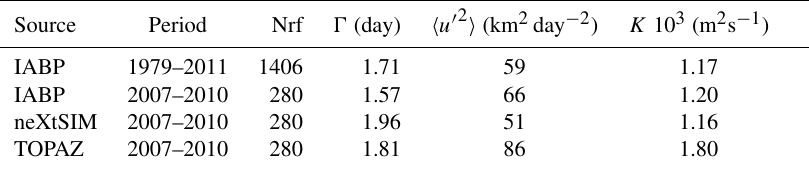
Table 1. This table shows the total number of floats (Nrf), the calculated integral timescale ( (cid:48) ), the variance (cid:104) u (cid:48) 2 (cid:105) and the calculated diffusivity K for the different dataset (IABP, TOPAZ and neXtSIM) and time periods used in this study. All these Lagrangian statistics were computed following the diffusion theory of Taylor (1921) and using L = 1000km and T = 250 days as averaging scales to calculate the Lagrangian mean